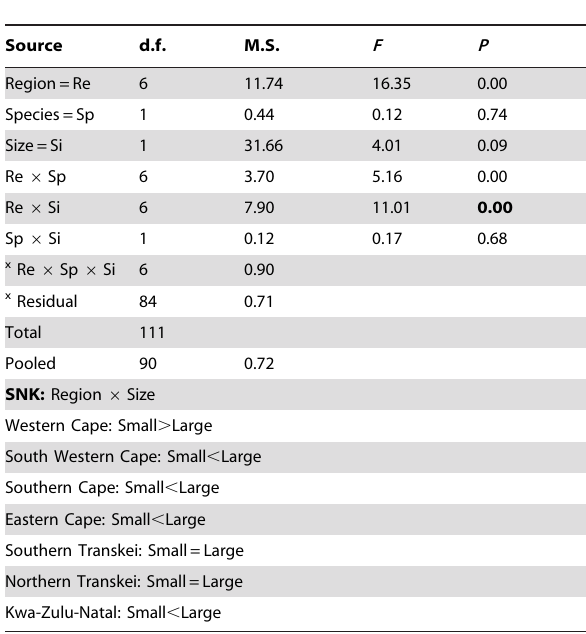
Table 3. Analysis of variance comparing within patch variance of Siphonaria concinna and S. serrata in 7 regions along the 1500 km of the limpets’ biogeographic range in small and large